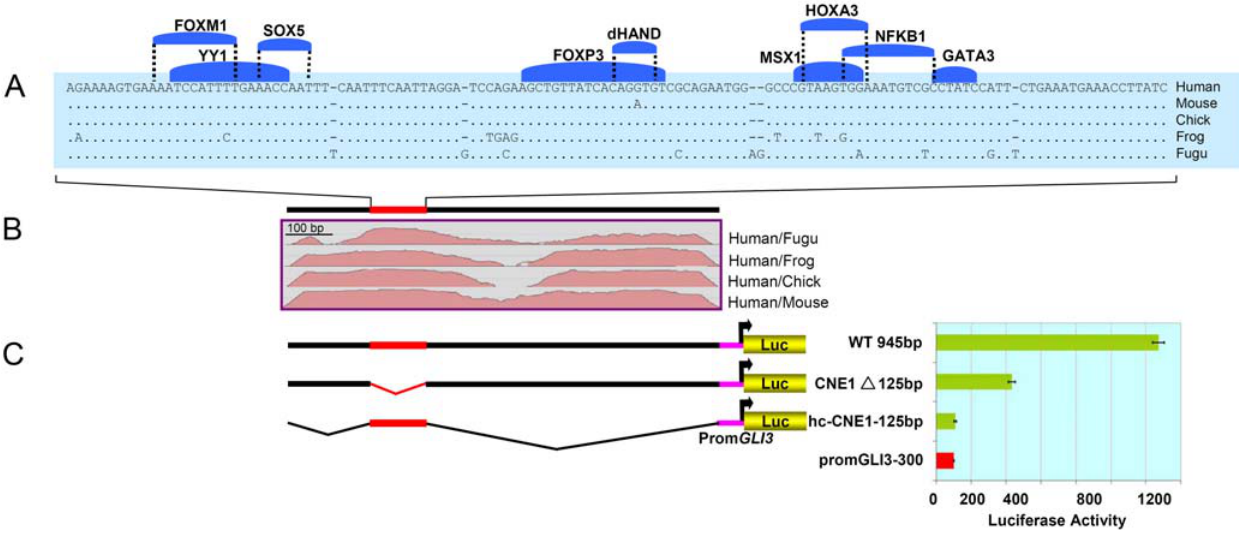
Figure 5. Deletion Analysis Reveals a Critical Role of hc-CNE1-125bp for the Regulatory Potential of CNE1. (A) BLASTZ alignment of a human, mouse, chick, frog, and Fugu highly-conserved 125 bp sequence fragment embedded within CNE1 shown with predicted conserved TFBSs (above). (B) SLAGAN alignment plots of human, mouse, chick, frog and Fugu CNE1 using human sequence as the base line. (C) Architecture of CNE1 wild type and deletion constructs, The red bar depicts the highly conserved region, and less well conserved regions are shown in black. Luciferase activity obtained in H661 cells after transient transfection of reporter constructs is shown in the diagram at the right side. Reporter gene expression is driven by CNE1 fragments upstream of the human GLI3 minimal promoter. The red bar depicts luciferase expression (100%) in H661 cells driven alone by the control GLI3 minimal promoter (Prom- GLI3 -300), while green bars represent the activity recorded for the vectors containing experimental reporter constructs.